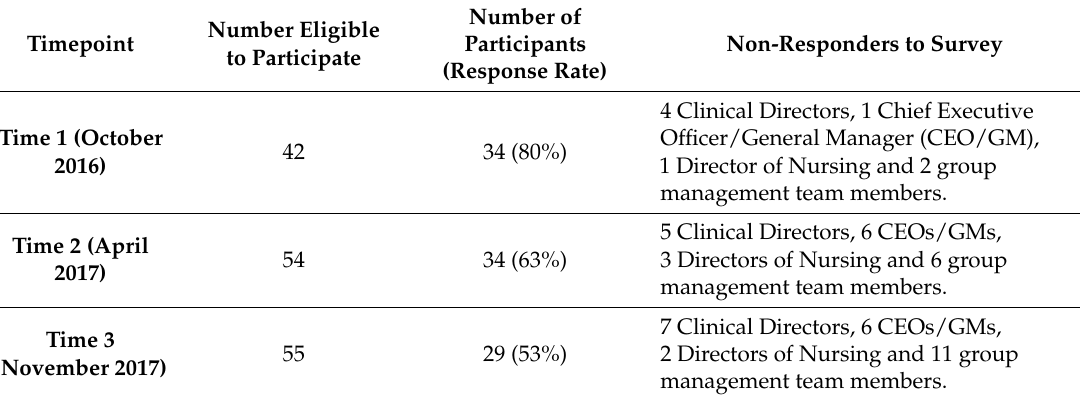
Table 1. Sample and response rates across time